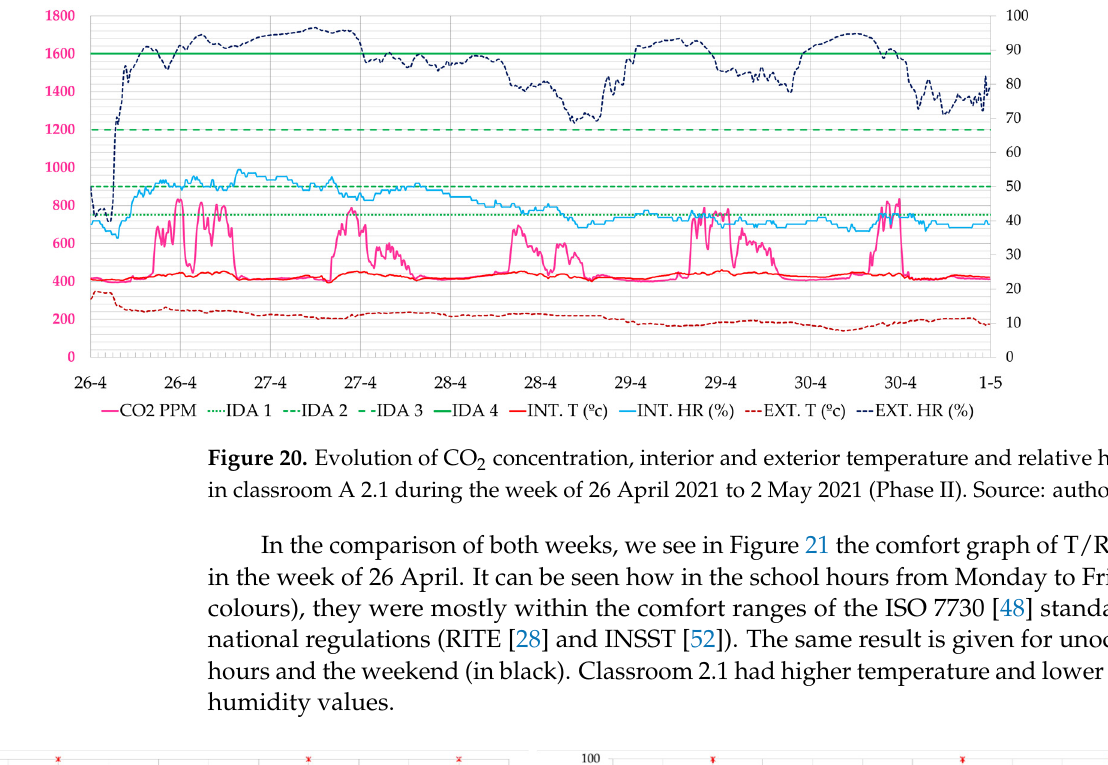
Figure 20. Evolution of CO 2 concentration, interior and exterior temperature and relative humidity